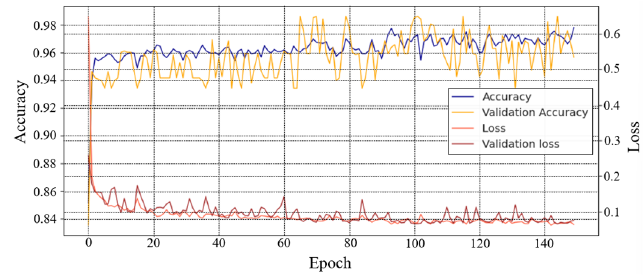
Figure 21. Training process of the ConvLSTM model.